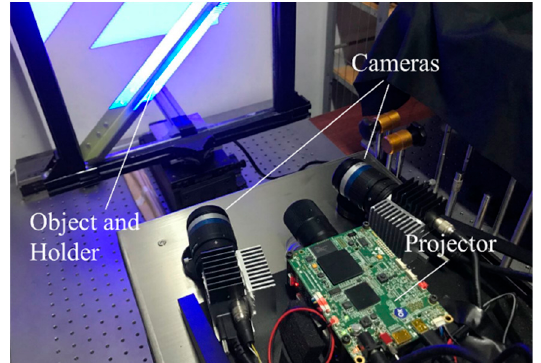
Figure 4. Experiment setup.